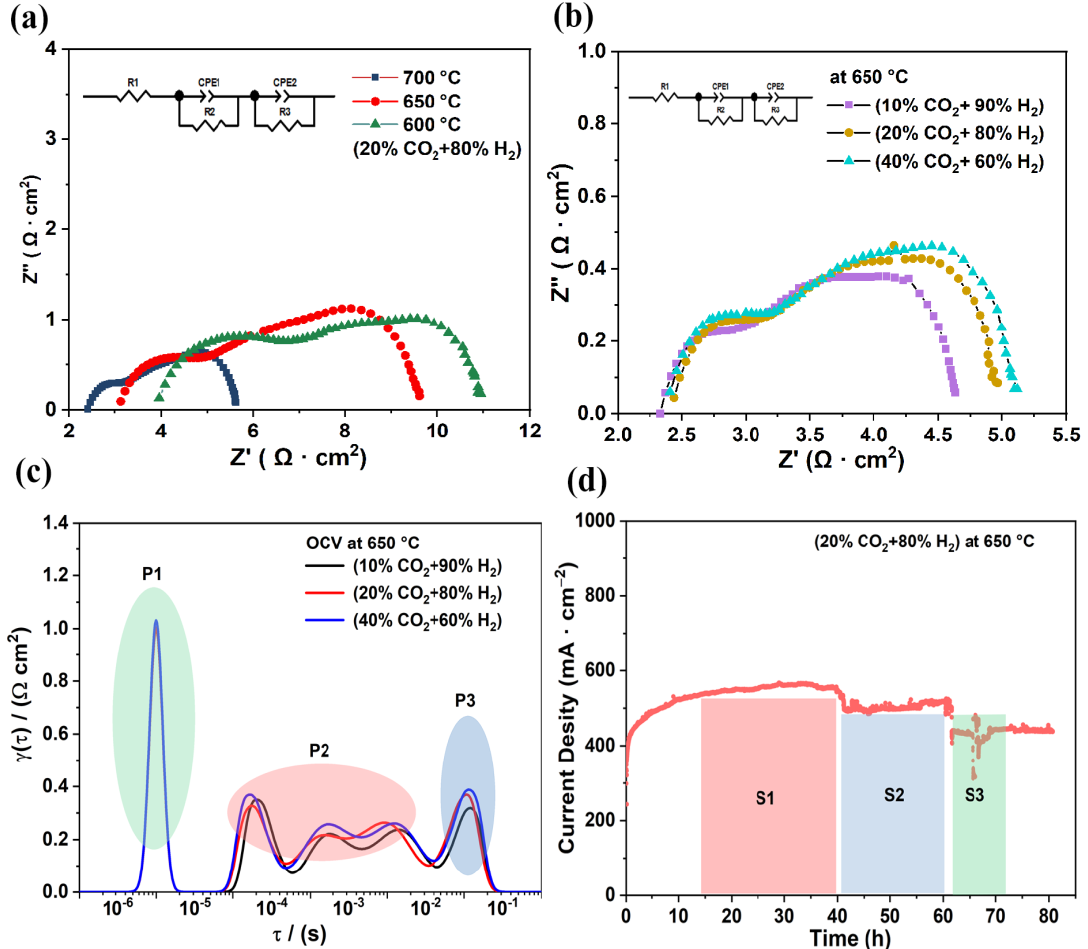
Figure 5. ( a ) EIS of electrolysis cell under 20% CO 2 – 80% H 2 in fuel electrode and 3% H 2 O – 97% air in air electrode at different temperatures. ( b ) EIS of cell at an applied voltage of 1.6 V at 650 °C: with 3% H 2 O – 97% air in air electrode, CO 2 concentration changed from 10% CO 2 – 90% H 2 to 40% CO 2 – 60% H 2 . ( c ) DRT curves from the EIS conversion. ( d ) Stability of cell at 650 °C and 1.6 V for 80 h: 20% CO 2 – 80% H 2 in the fuel electrode and 3% H 2 O – 97% air in the air electrode.